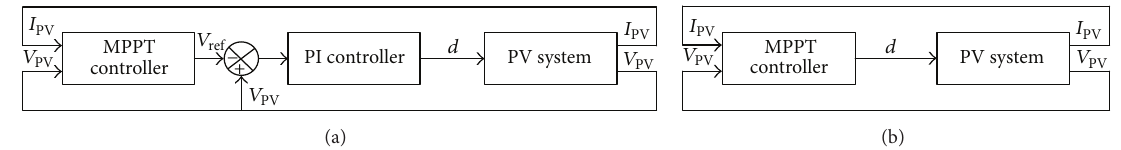
Figure 1: Block diagrams of INC MPPT algorithms implementation techniques; (a) reference voltage control; (b) direct duty ratio control.